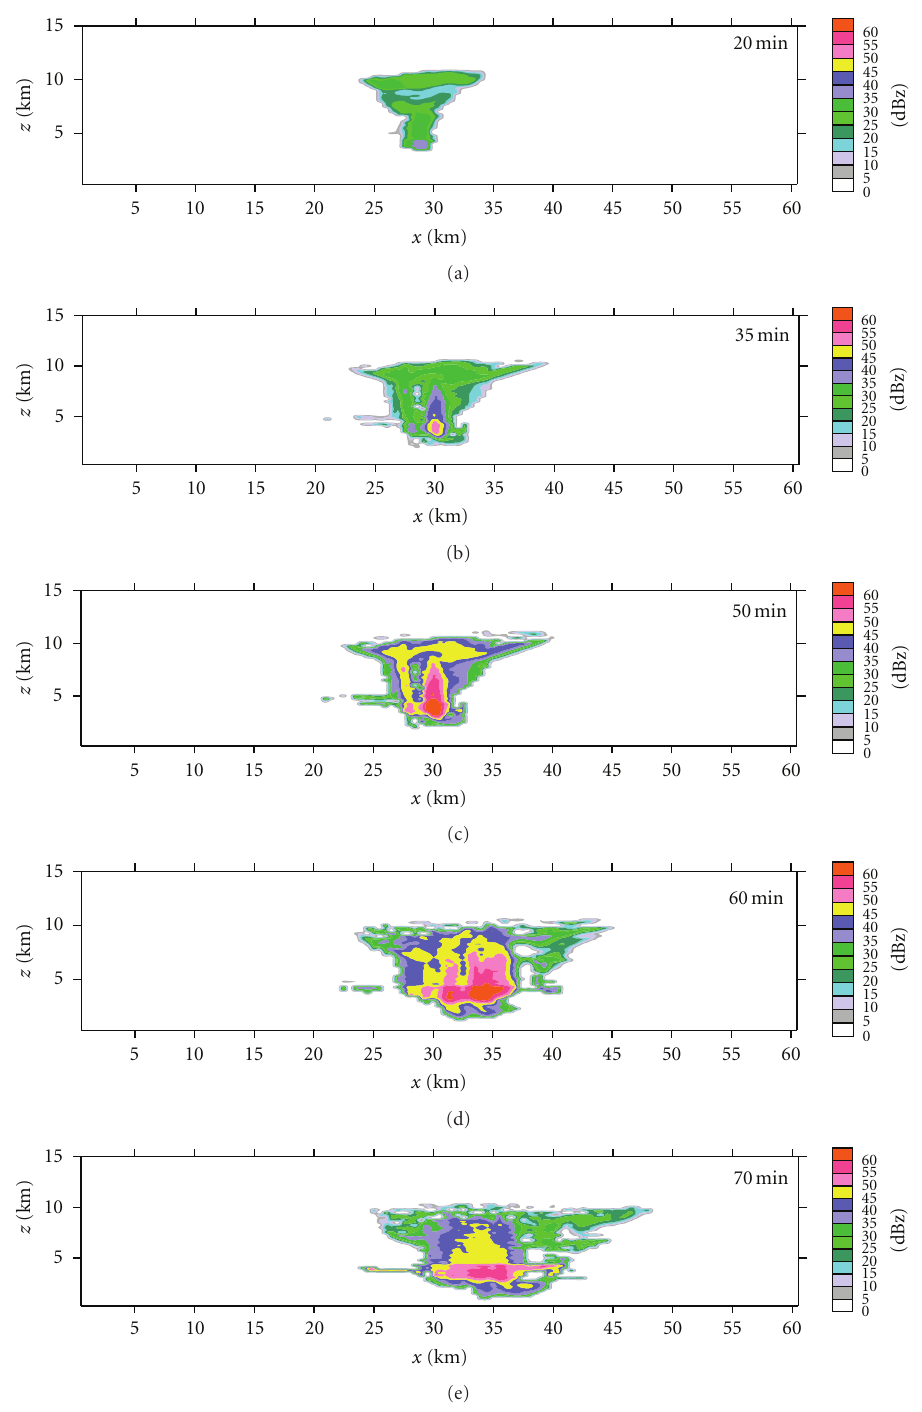
Figure 6: The same as Figure 5, except for using a finer spatial and temporal resolution into the model initialization. Model run